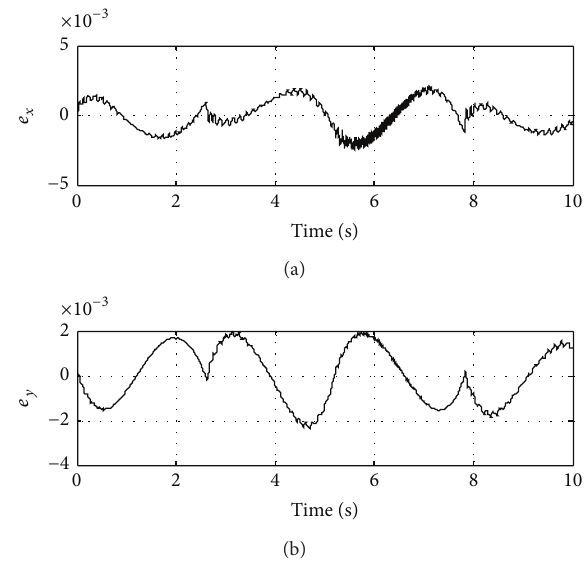
Figure 13: Workspace tracking errors. (a) 𝑥 -position tracking errors and (b) 𝑦 -position tracking errors.